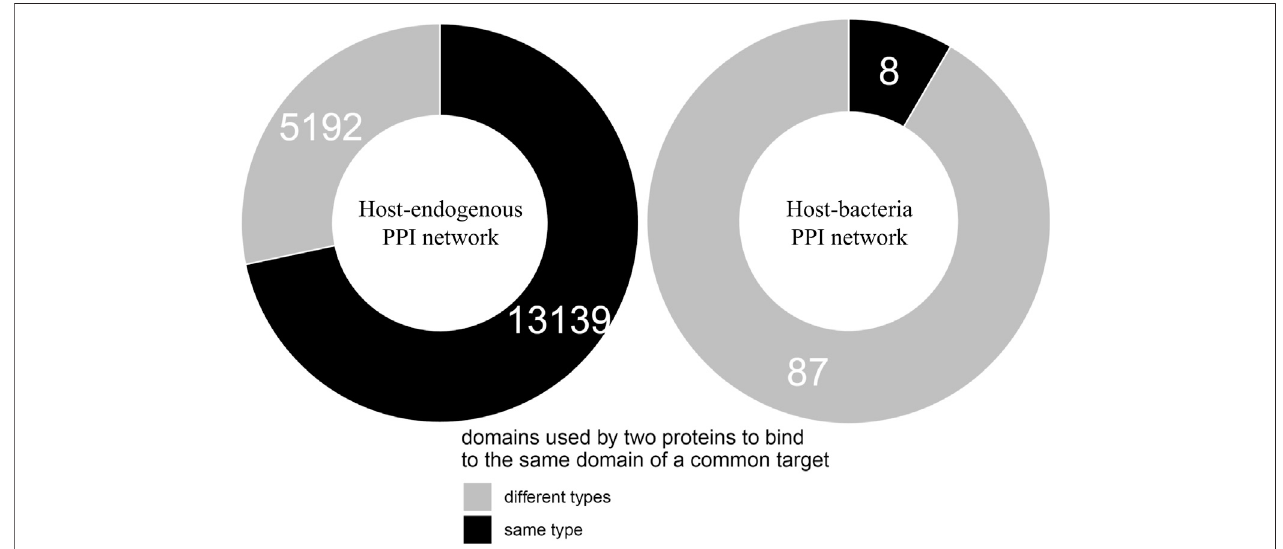
FIGURE 1 | Different evolutionary mechanisms for binding site sharing in the host-endogenous vs. host-bacteria PPI network. Two host proteins are more likely to usethesametypeofdomaintobindtothesamedomainofacommontarget,suggestingdivergentevolutionfollowedbygeneduplication.Ahostproteinandabacterial protein are more likely to use different types of domain to bind to the same domain of a common host target, suggesting convergent evolution (or extreme divergent evolution) of non-host-like domains in bacteria. The difference in dominant evolutionary mechanisms is statistically signi fi cant (Fisher ’ s exact test, two-tailed p < 2.2 * 10 − 16